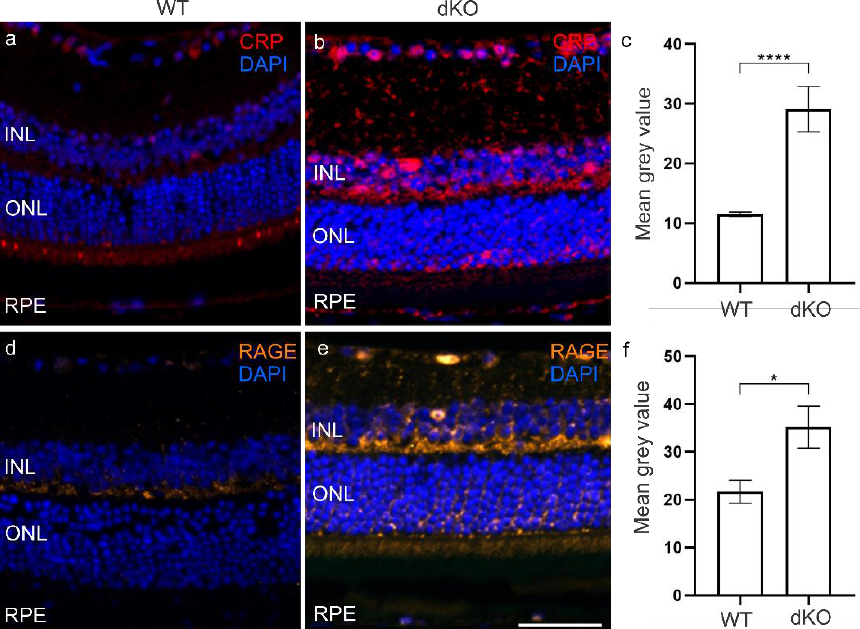
Figure 5. The CRP levels in the dKO retina ( b , c ) were significantly increased by ~150%, **** p = 0.0001, and RAGE levels by ~60%, * p = 0.01 ( e , f ), as compared to WT retinas ( a , d ). Scale=20